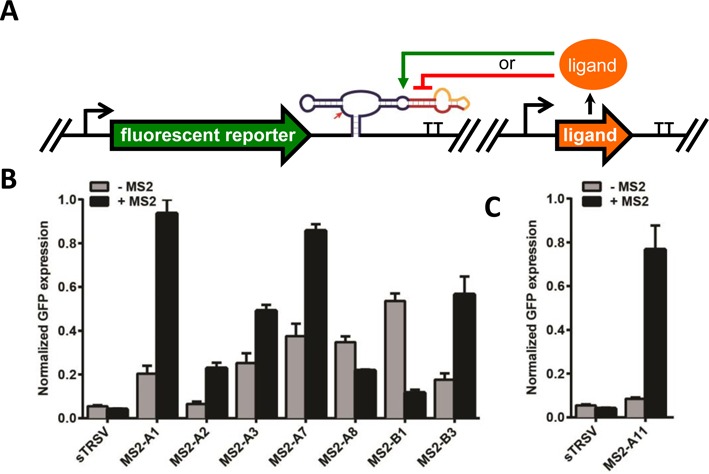
In vivo activity of protein-responsive ribozyme switches in yeast cells. (A) Schematic of the protein-responsive ribozyme switch characterization system for yeast. An expression construct encoding the ribozyme switch in the 3′ UTR of a fluorescent reporter (GFP) is encoded on a low-copy plasmid. A separate low-copy plasmid encodes the expression of the protein ligand (or an empty control). (B) Gene-regulatory activity of MS2-responsive ribozyme switches in yeast. (C) Gene-regulatory activity of optimized ribozyme switch (MS2-A11) in yeast. Relative GFP levels are reported for cells harboring the indicated ribozyme switch constructs or controls in the absence and presence of MS2. Reported values are the geometric mean ± SD from biological triplicates and normalized to the non-cleaving control (sTRSVctrl).